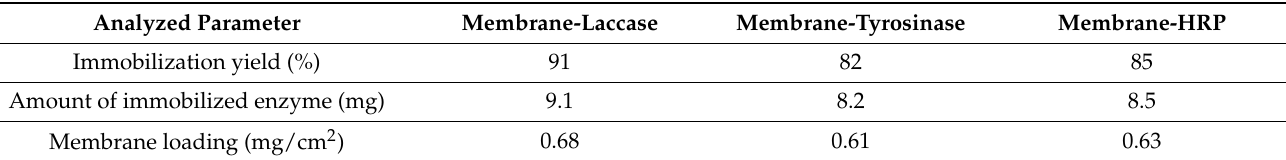
Table 1. Characterization of enzyme immobilization including calculation of immobilization yield, amount of immobilized enzyme, and membrane loading. All values are presented as a mean value, and which error value does not exceed